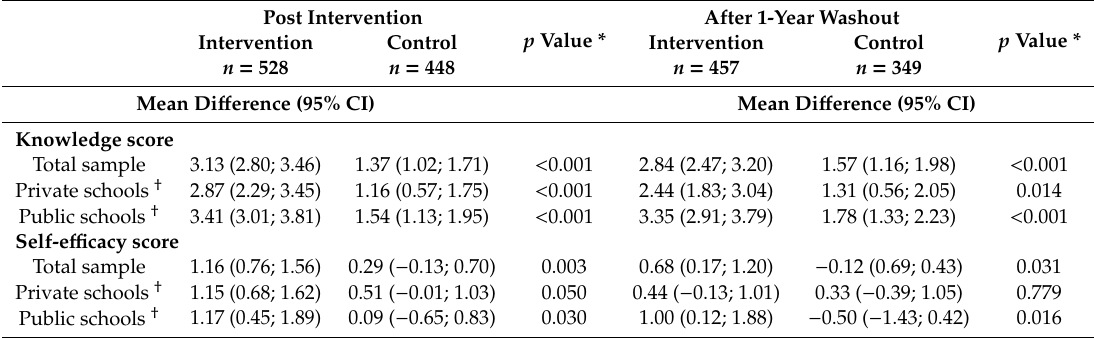
Table 5. Change in average knowledge and self-e ffi cacy scores in intervention vs. control at post-intervention and after